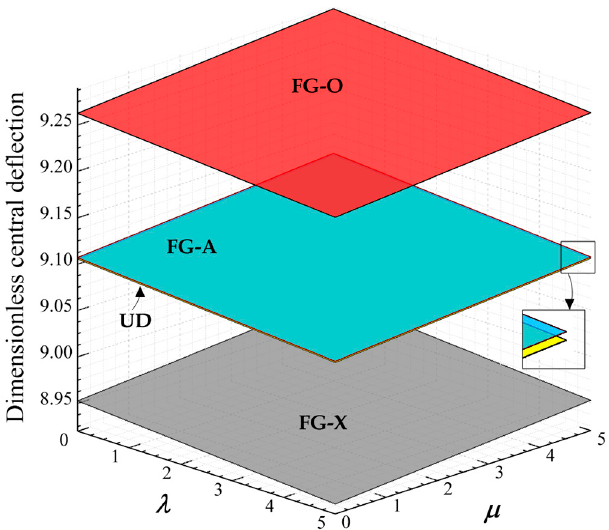
Figure 10. Effect of nonlocal and small-scale parameters on the dimensionless central deflection of simply supported GRNC plate for various GPLs reinforcement patterns (g (cid:2891)(cid:2900)(cid:2896)∗ = 1%) . In Figure 11, dimensionless central deflection versus the length-to-thickness ratio of the GPLs nanofillers using various GPLs reinforcement patterns is demonstrated. It is clear that the increase in the thickness-to-length ratio a GPL / h GPL leads to a decrement in dimensionless central deflection.